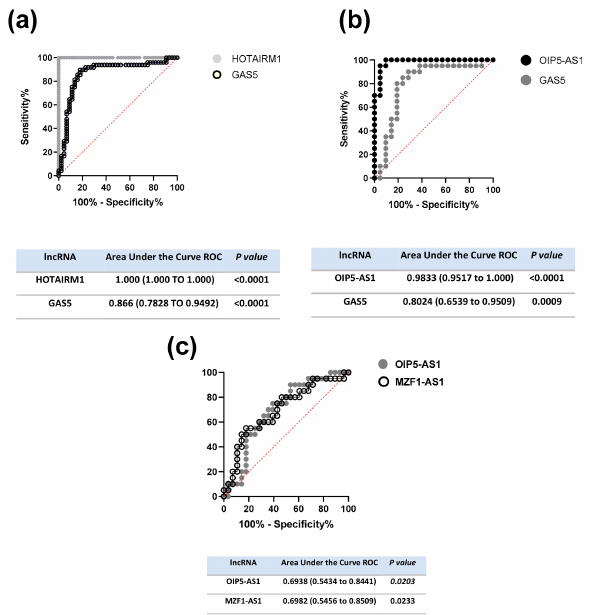
Figure 2. Discriminative value of lncRNAs between interest groups ( a ) Area under the curve ROC analysis of HOTAIRM1 and GAS5 to discriminate between two endotypes of asthma (AA and OA) from their respective controls (HA and OB groups); ( b ) Area under the curve ROC analysis of OIP5-AS1 and GAS5 to discriminate between obesity alone from obesity-related asthma patients; ( c ) Area under the curve ROC analysis of OIP5-AS1 and MZF1-AS1 to discriminate between two major asthma